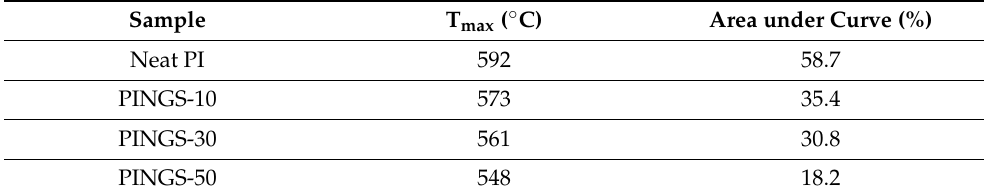
Table 2. Summary data from derivative curves.